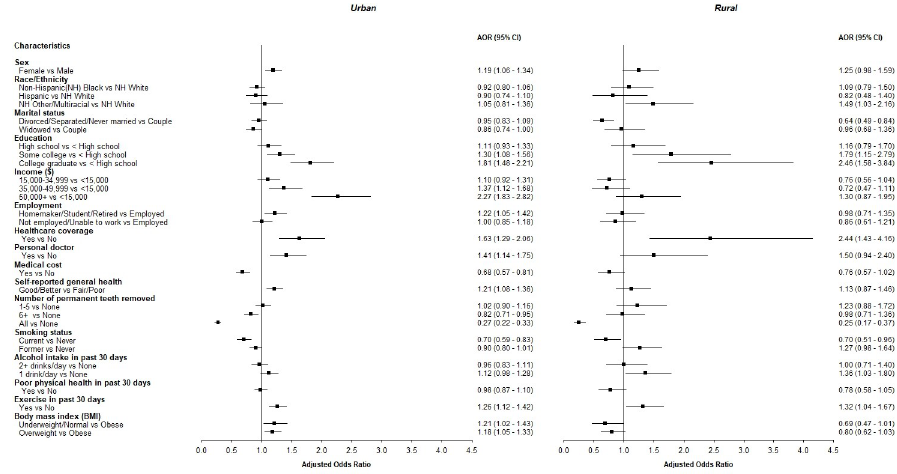
Fig 2. Dental visit compliance by residential status. Odds ratios (OR) and 95% CI for dental visit compliance by urban and rural residence status adjusted for sex, age, BMI, race/ethnicity, marital status, education, employment, smoking status, self-reported general health, healthcare coverage, having a personal doctor, perceiving medical cost as a barrier, exercise in the past 30 days, average alcohol intake in the past 30 days, poor mental or physical health in the past 30 days, annual household income, and number of permanent teeth removed (n = 40,585; N = 19,281,982). Only variables with a significant association for either residential status are shown. Full details are available in